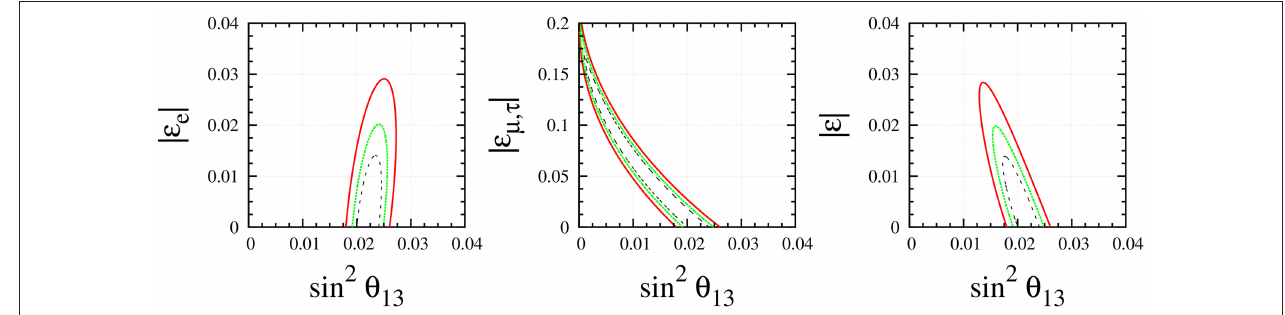
FIGURE 6 | 68, 90, and 99% C.L. allowed regions from Daya Bay for different scenarios involving CC NSI (Left) of only ν e ; i.e., ǫ udP ee , (Middle) of only ν µ or ν τ ; i.e., ǫ udP µ e or ǫ udP τ e , and (Right) simultaneously of all neutrino flavors with ǫ = ǫ udP ee = ǫ udP µ e = ǫ udP τ e . In drawing the figures, 5% uncertainty on the total event rate normalization of Daya Bay events was assumed. Plots are taken from Agarwalla et al. [13], published under the terms of the Creative Commons Attribution Noncommercial License and therefore no copyright permissions were required for their inclusion in this